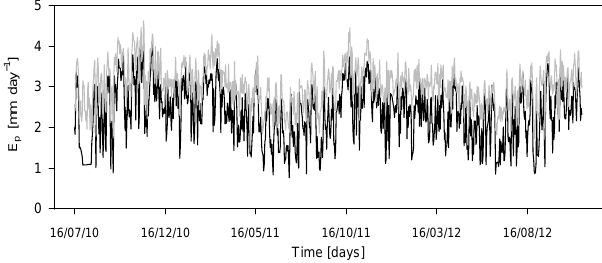
Figure 3. The potential evapotranspiration E p for Calluancay (black) and Cumbe